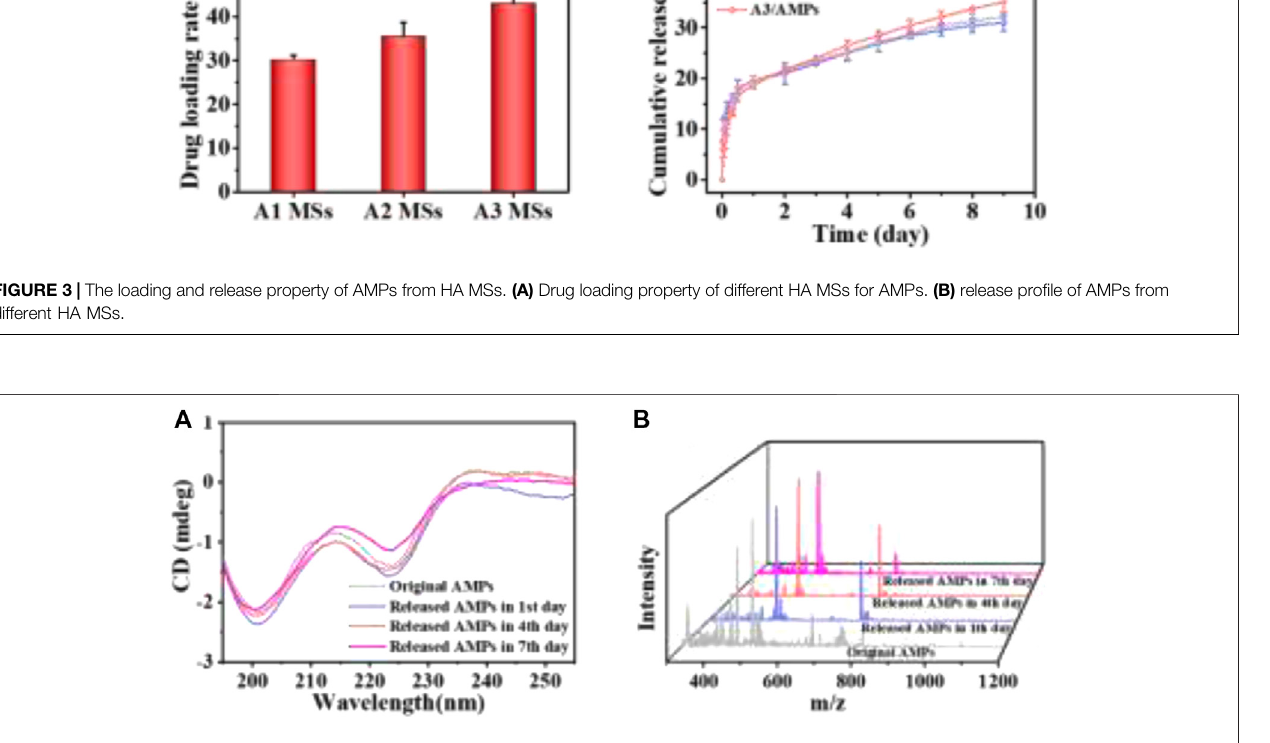
FIGURE 4 | The stability assessment of AMPs released from the representative HA MSs. (A) Far-UV CD spectra. (B) Mass spectrometry spectra.